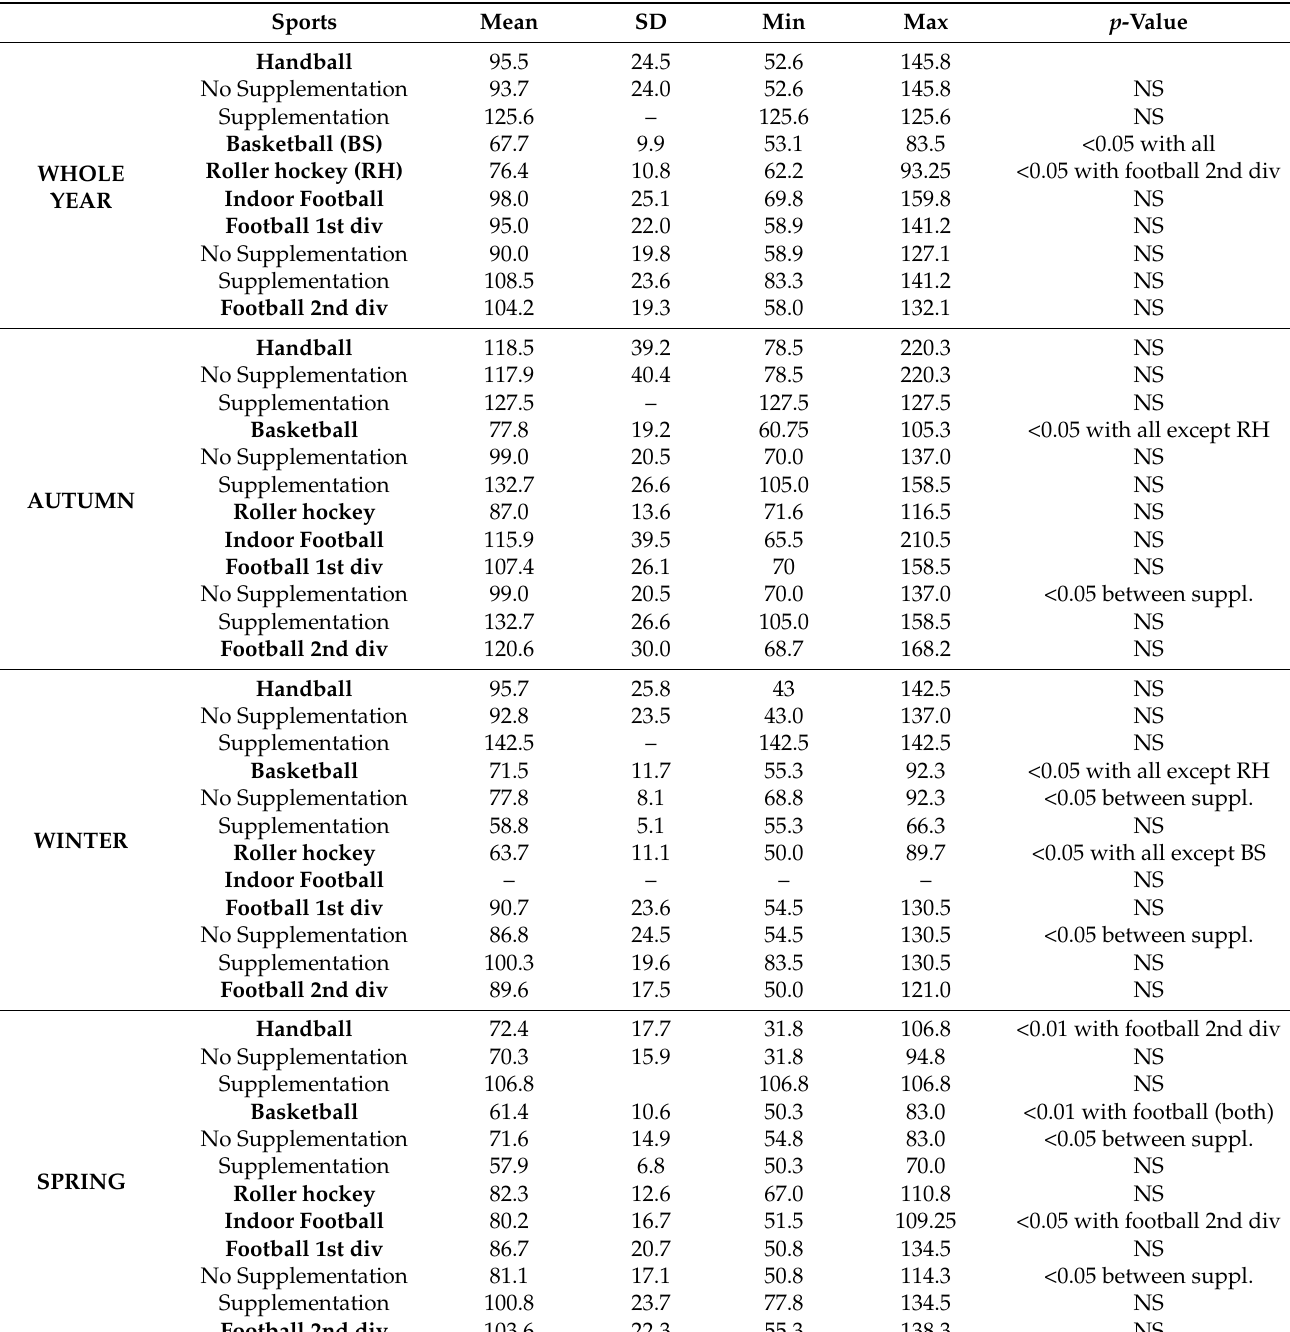
Table 3. Descriptive mean values of vitamin D concentrations (nmol/L) as mean, SD, minimum, and maximum according to season, sport modality, and